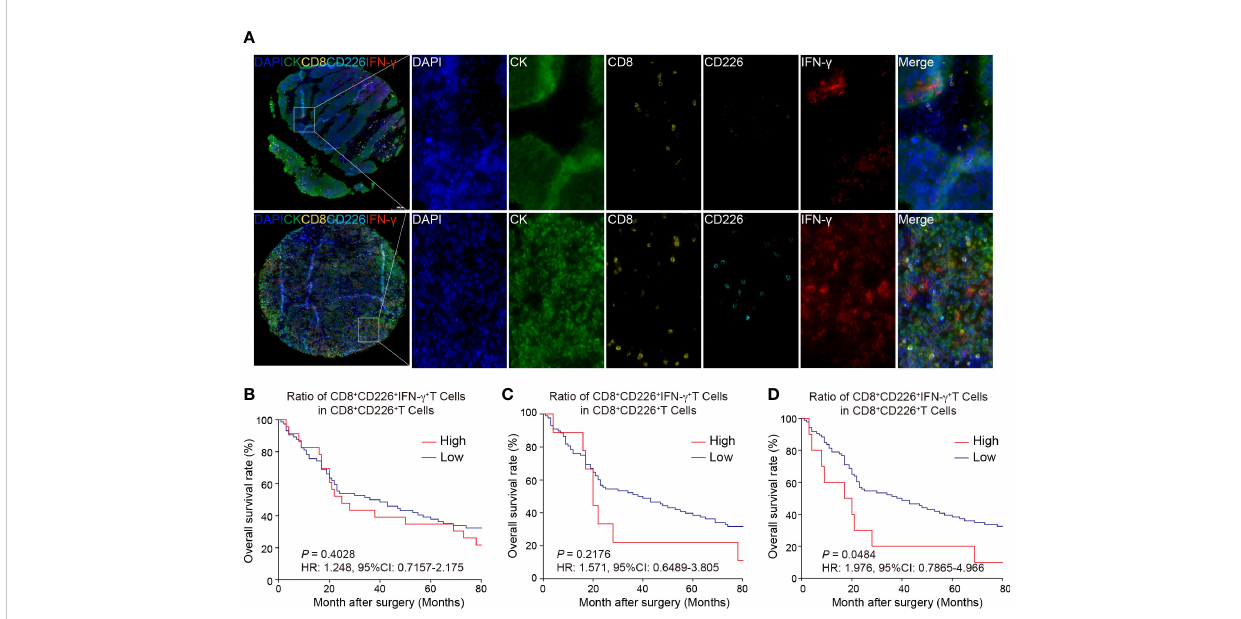
FIGURE 4 Multi-colored immunostaining of CD8, CD226, IFN- g , and the prognostic value of CD226 + CD8 + IFN- g + TILs in human GC. (A) . Representative images for staining of CD226 + CD8 + IFN- g + TILs in GC tissues and normal tissues. (B – D) . OS rates strati fi ed by the ratio of CD8 + CD226 + IFN- g + TILs in CD8 + CD226 + TILs in GC tissues (B) . whole tissues, (C) . epithelial cell region, (D) . stromal cell